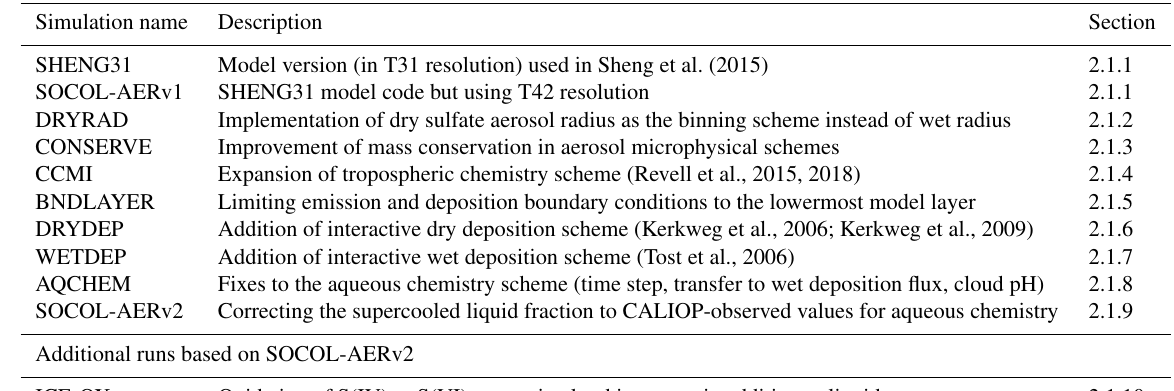
Table 1. Description of the year 2000 time-slice simulations that were produced during the development of SOCOL-AERv2. Each simulation builds on the previous one, adding new features or correcting a certain process in the model. Two additional sensitivity runs are also listed that reduce the cross-tropopause transport of SO 2 and tropospheric sulfate